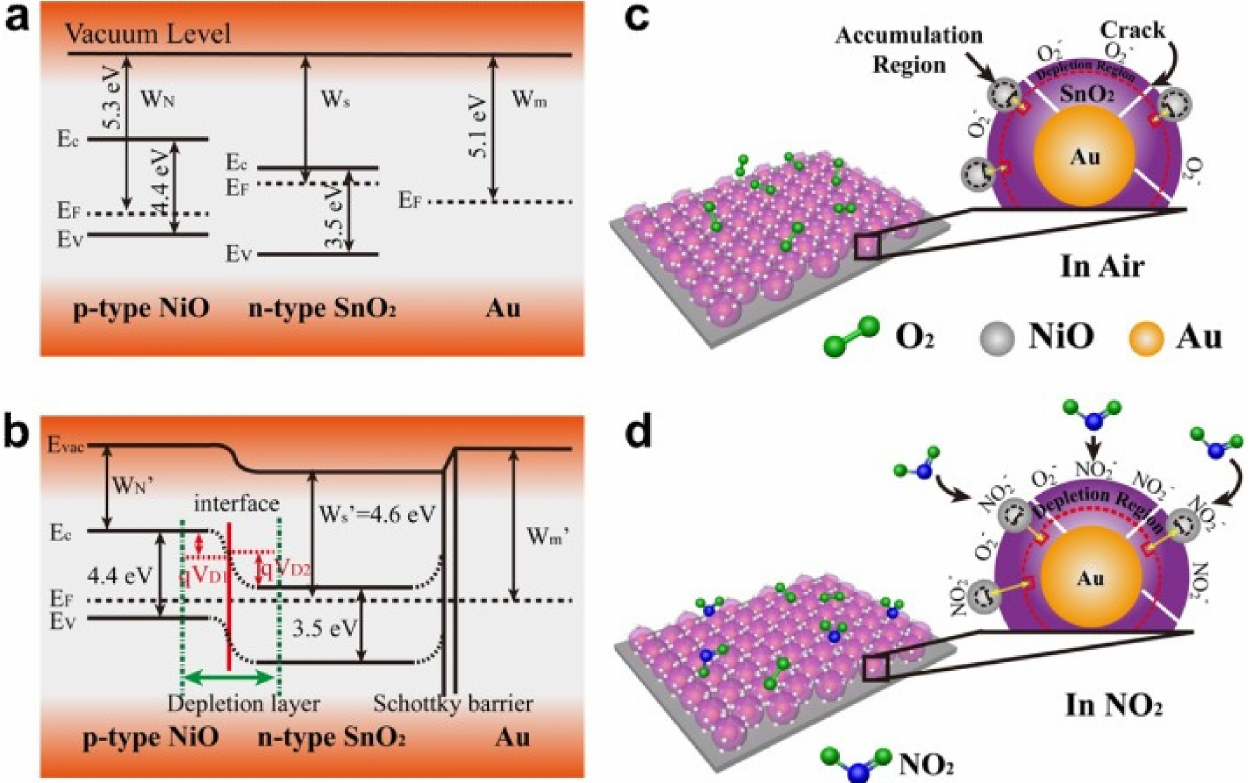
Figure 20. Schematics showing the NO 2 sensing mechanism. ( a ) Schematic diagram of the energy- band configurations for NiO, SnO 2 , and Au. ( b ) Energy—band diagram of Au/SnO 2 /NiO hetero- junction. ( c , d ) Schematic model for the Au/SnO 2 /NiO sensor exposed in air and NO 2 , respectively. The outside part of SnO 2 indicated by red dashed lines is the depletion region. The black dashed lines in NiO show the accumulation region. White narrow strips indicate the existing cracks in SnO 2 formed during thermal annealing. Reprinted with permission from